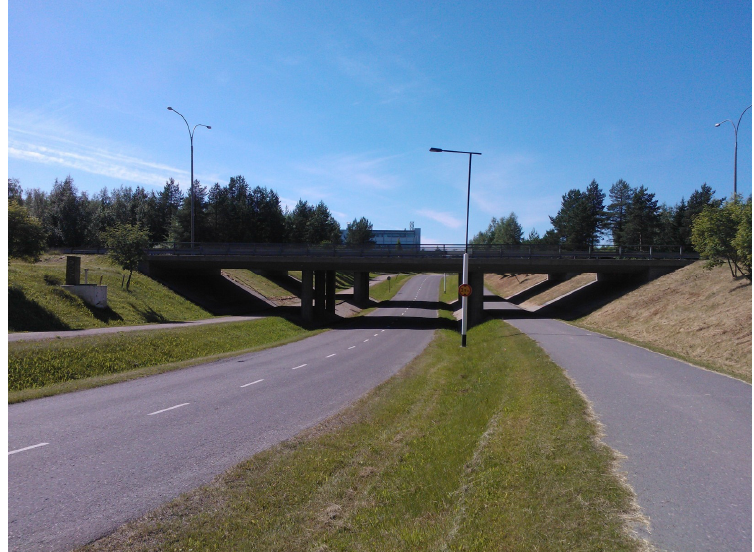
Figure 17. Example of shade from a highway bridge.